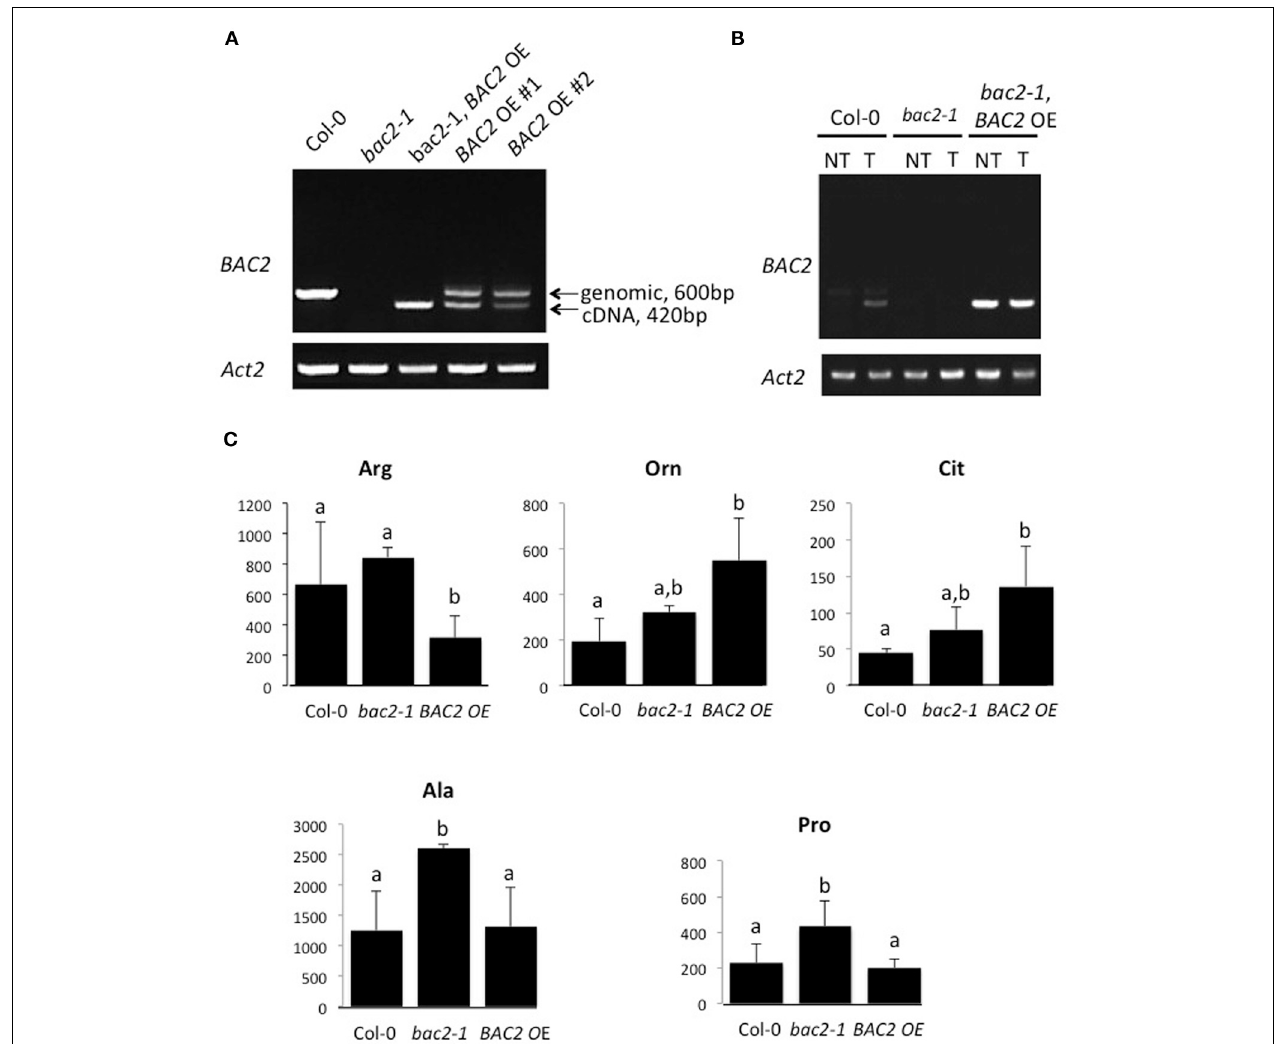
FIGURE 2 | BAC2 overexpression and amino acid content of 8-day-old Arabidopsis seedlings. (A) PCR on genomic DNA of Arabidopsis Col-0, bac2-1 , p35S:BAC2 in bac2-1 genetic background (named bac2-1, BAC2-OE ) p35S:BAC2 in Col-0 (named BAC2-OE #1 and BAC2-OE #2). Arrows indicate BAC2 genomic DNA and cDNA sizes. ACT2 was used as a control of genomic DNA quality. (B) Semi-quantitative RT-PCR. BAC2 expression levels were detected in Arabidopsis Col-0, bac2-1 , and p35S:BAC2 in bac2-1 (named bac2-1, BAC2-OE ) seedlings non-treated